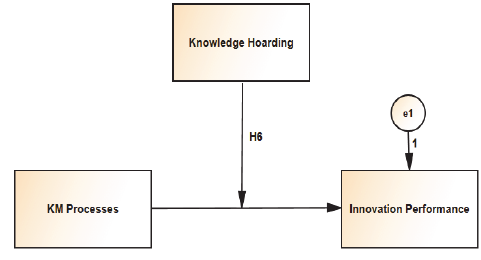
Fig. 2. Perceptual model of moderation hypothesis